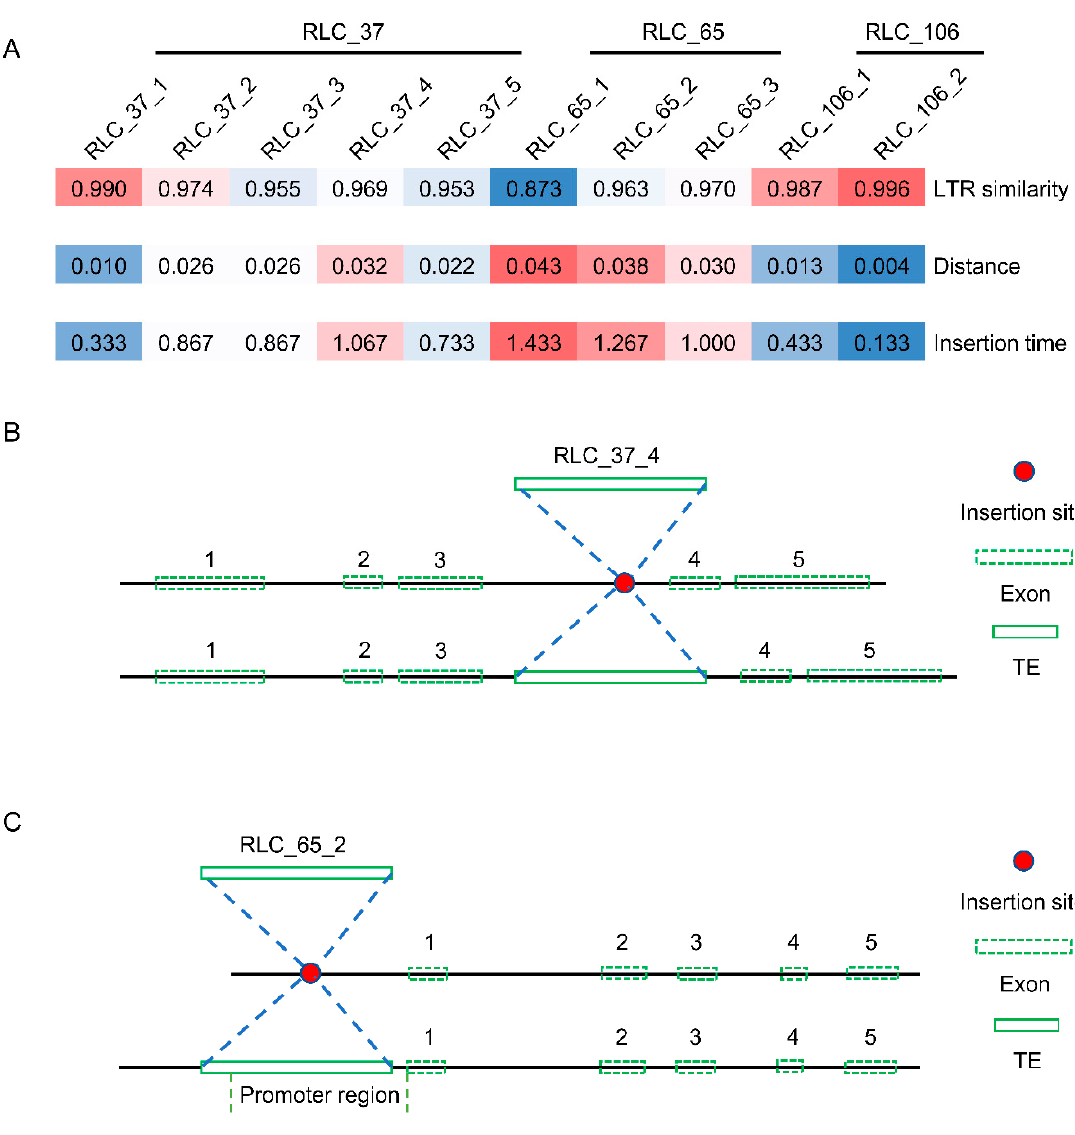
Figure 8. Insertion time and position analysis of three Copia families. ( A ) Insertion time analysis of the three Copia families. The “distance” here means the K values, which were used to calculate the insertion time using the equation T = K / 2r ; ( B ) Insertion position structure of the RLC_34_4 element. RLC_37_4 was inserted into the third intron of a mulberry gene (NCBI reference sequence, XM_010093293); ( C ) Insertion position structure of the RLC_65_2 element. RLC_65_2 was inserted into the promoter region of a mulberry gene (NCBI reference sequence, XM_010114426). Red plot means insertion site. Green box with dashed line means the exon. Numbers 1–5 correspond to exons 1–5. Green box with a solid line means the corresponding TE element. Figure 8B,C was drawn according to the actual length of each exon.